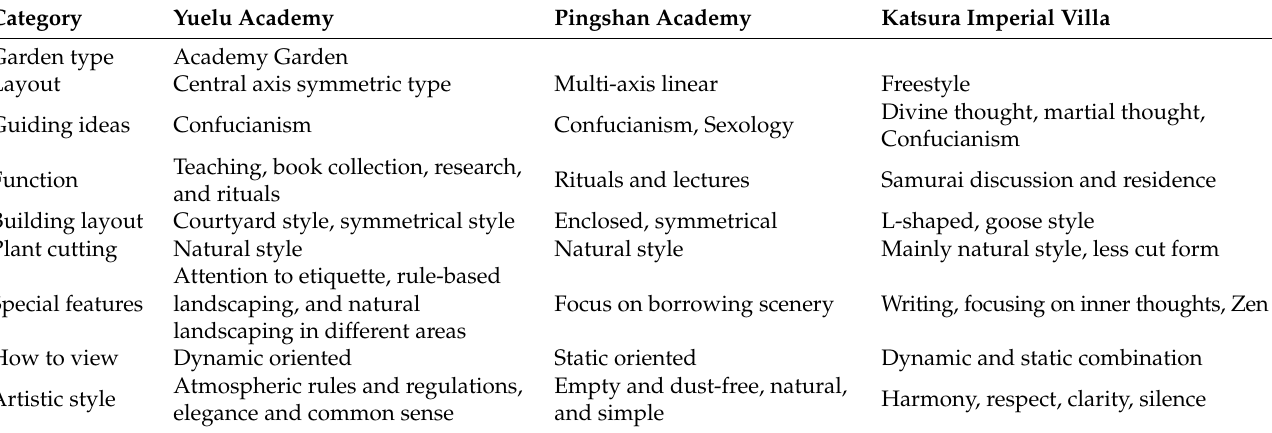
Table 4. Comparison of Chinese, Japanese and Korean Academy